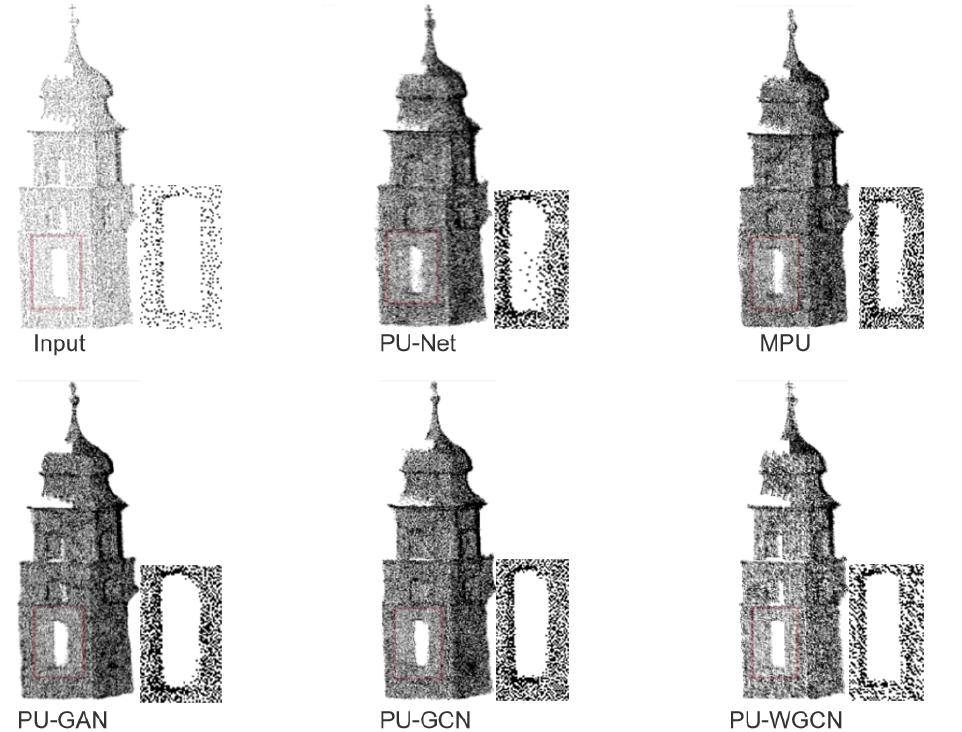
Figure 16. Visualization of the results in real scenes of group f. We show the upsampled results when processed the input point cloud by different upsampling networks (PU-Net, MPU, PU-GAN, PU-GCN and our PU-WGCN).PU-WGCN retains the hole information of the building well.